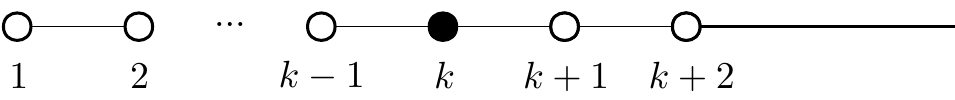
Figure 2 . Y system for current perturbed SU(2) k WZNW. The k ’th node is the physical rapidity. The j ’th node is kink magnon string of length k (cid:0) j for 1 (cid:20) j (cid:20) k (cid:0) 1. The a ’th node is SU(2) magnon string of length a (cid:0) k for a (cid:21) k +